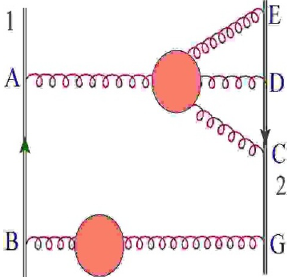
Figure 7. Skeleton diagram C 1 for the Cweb W (1 , 0 , 1)